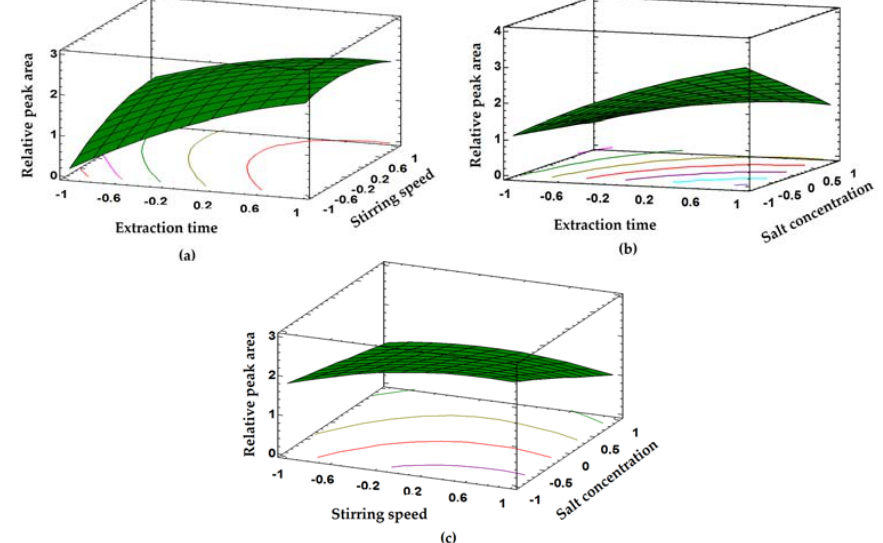
Figure 4. Response surfaces obtained from Box ‐ Behnken design for naproxen: ( a ) extraction time vs. stirring speed; ( b ) extraction time vs. concentration of NaCl; and ( c ) stirring speed vs. concentration of NaCl.